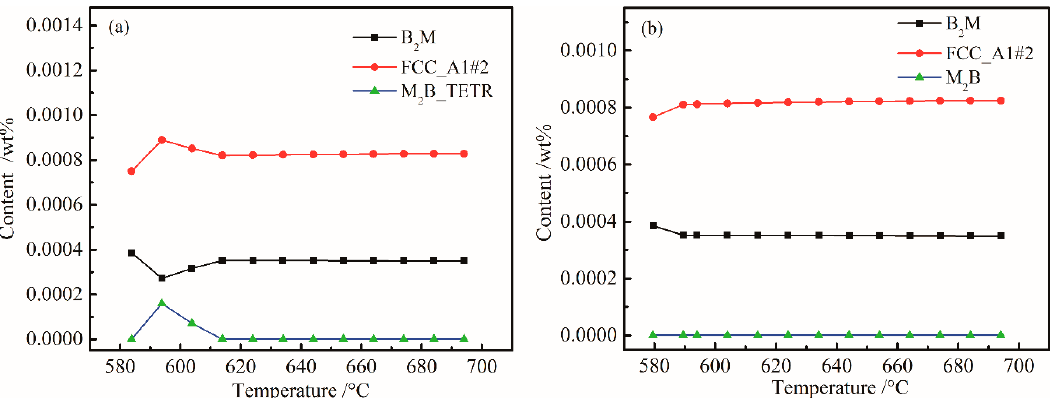
Figure 5. Plots of B 2 M, FCC_A1#2, and M 2 B_TETR content versus temperature: ( a ) 0.01 wt % W and ( b ) W-free.